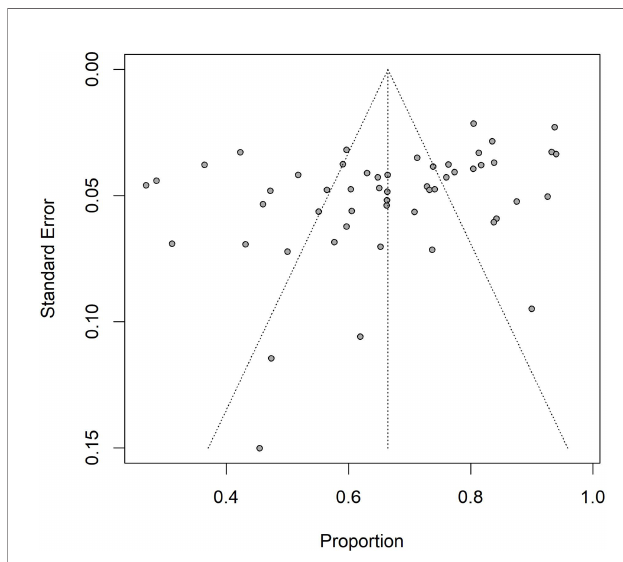
FIGURE 3 | Funnel plot for the pooled prevalence of Helicobacter pylori in non- cardia gastric cancer in